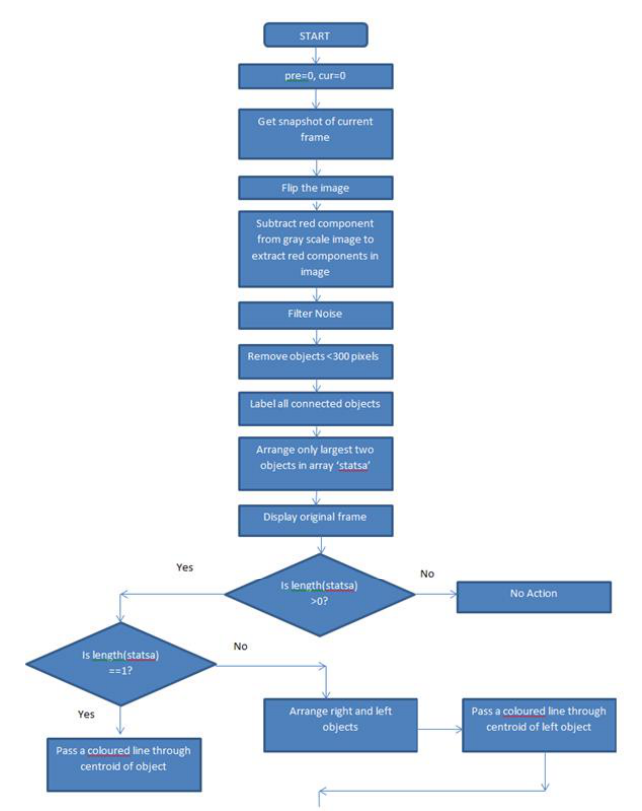
Figure 3 . Project Flowchart - Part